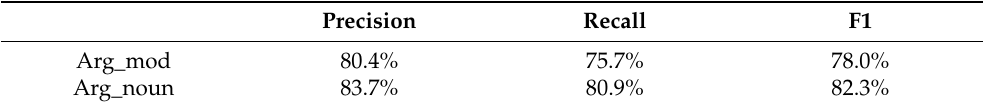
Table 10. Results of FP attribution